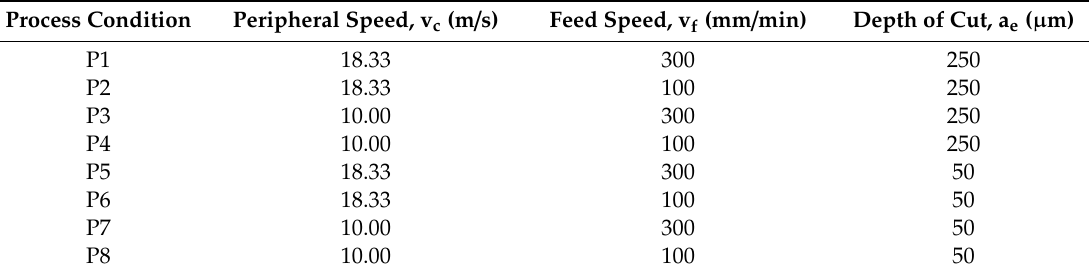
Table 3. Design of the process conditions in this study.